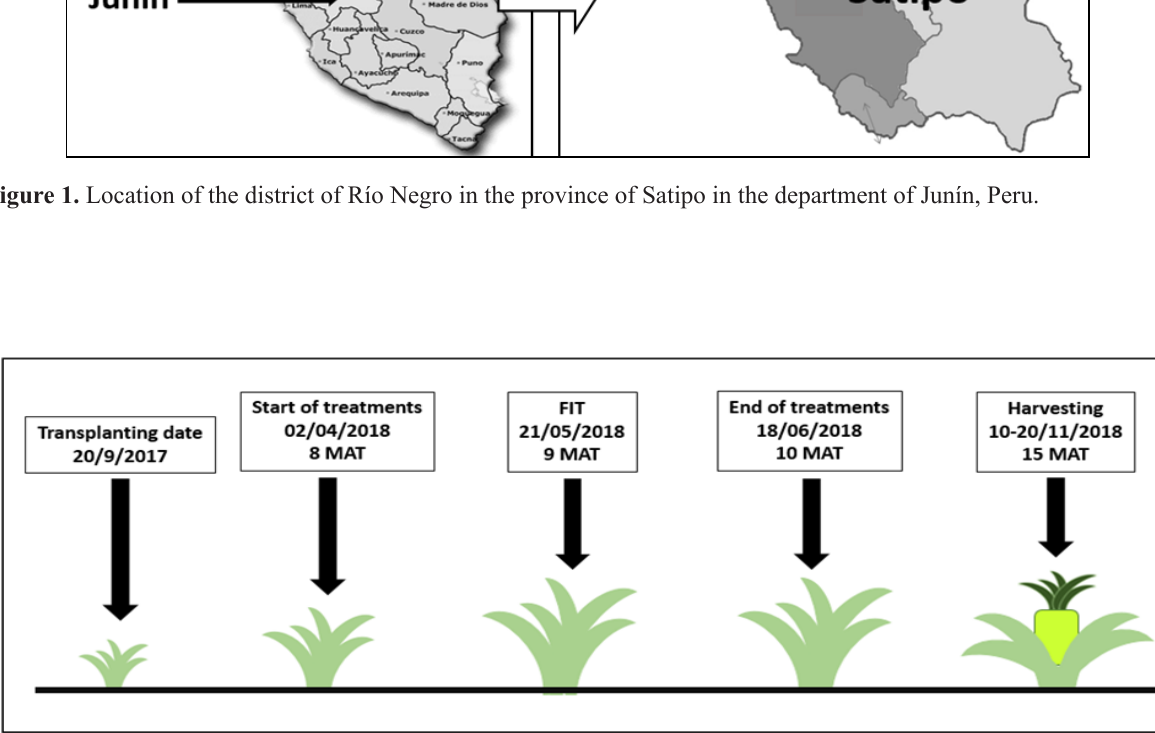
Figure 2. Key dates in the management of the MD2 pineapple experiment in Satipo. MAT, months after